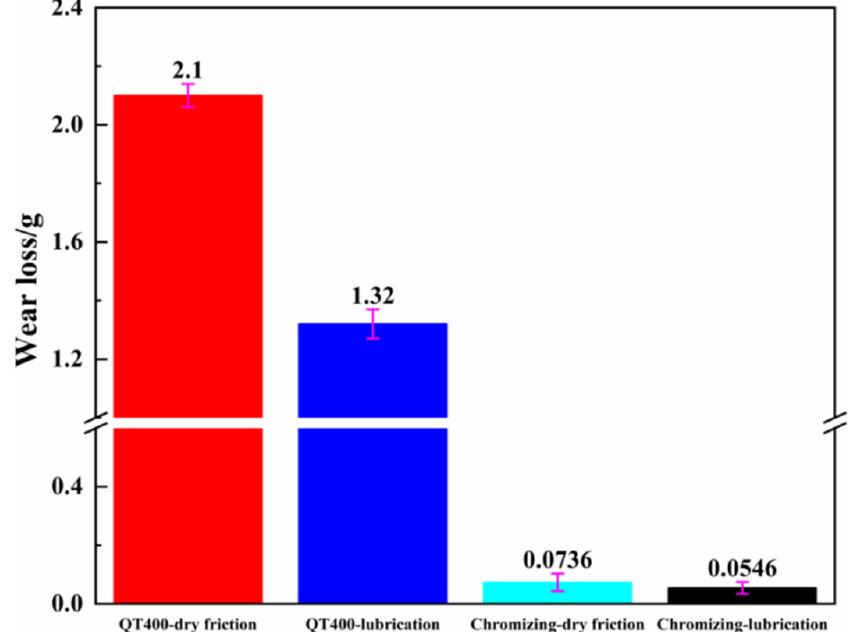
Figure 10. Wear loss of each sample under dry-friction and lubrication conditions.